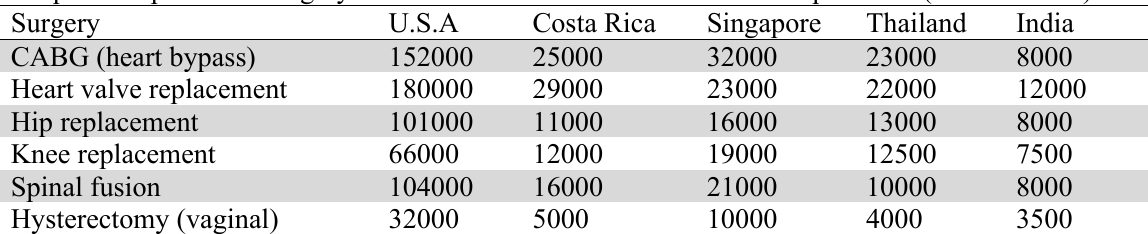
Comparative prices for surgery and treatment in different countries in April 2010 (In US dollars)